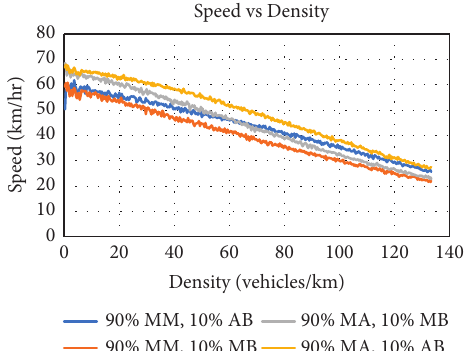
Figure 42: Flow rate vs. total no. of vehicles fundamental diagrams for different compositions of MA, MM, AB, and